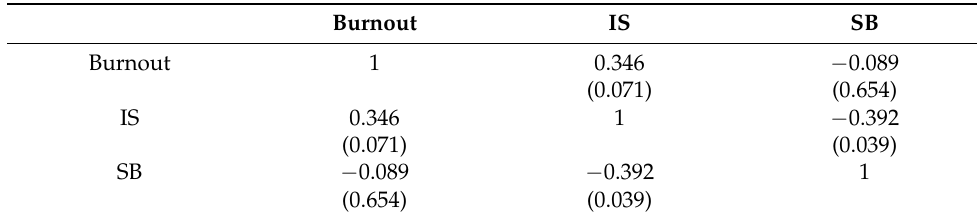
Table 3. Correlation among dimensions.